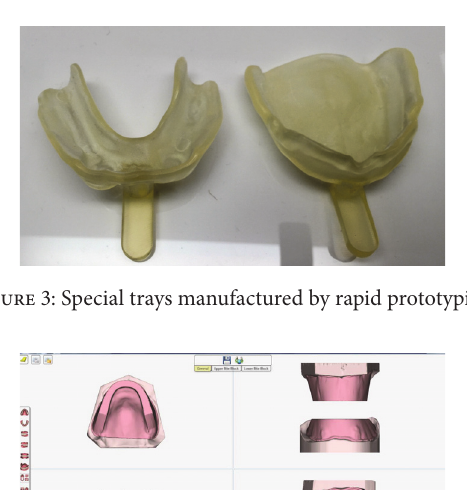
Figure 2: Design of special trays.